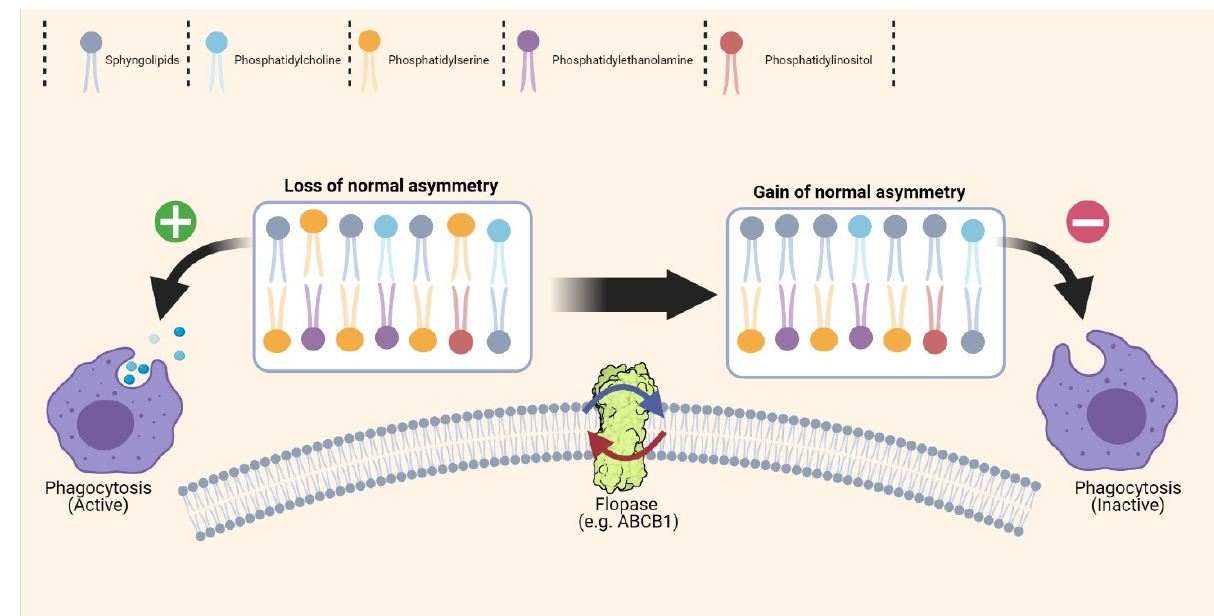
Figure 2. Cell membrane phospholipid composition. In physiological conditions, the cell membrane is characterized by an asymmetric distribution of phospholipids, but this feature is lost during normal cell ageing. For example, in erythrocytes and platelets, phosphatidylserine relocation from the inner leaflet to the outer leaflet of the membrane facilitates the phagocytosis of apoptotic cells and older cells. Normally, the membrane lipid distribution profile is regulated by specific proteins, such as flipases and flopases, and cancer cells might overexpress these proteins to support their high proliferation rate and to avoid phagocytosis. This mechanism might also be necessary for the biogenesis of extracellular vesicles to avoid their unspecific uptake. Nevertheless, in cancer cells, loss of the lipid distribution asymmetry might help to interact with other cells or might facilitate platelet activation on their surface.